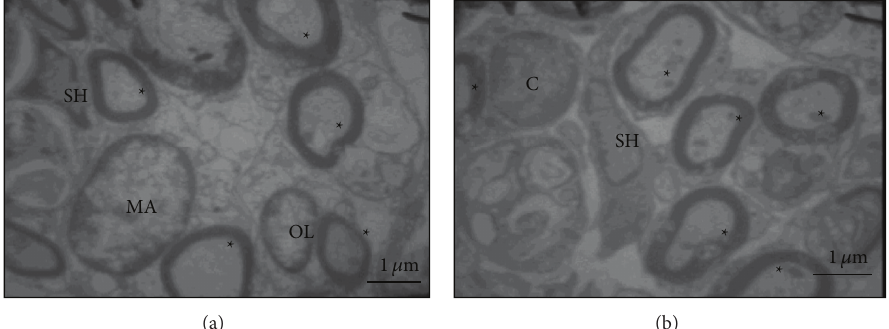
Figure 8: Electron photomicrography of distal stump to spinal cord. (a) PPN; Schwann cell (SH) interacts with a myelinated axon (*); an oligodendrocyte (OL) can also be observed beside an axon, and a macrophage (MA) is seen in the left corner (1600x); (b) BMSC interacts (C) with a Schwann cell (SH) beside a myelinated axon (*) (4646x). The images were taken with a transmission electron microscope LEO 906 E. Calibration bar 1 𝜇